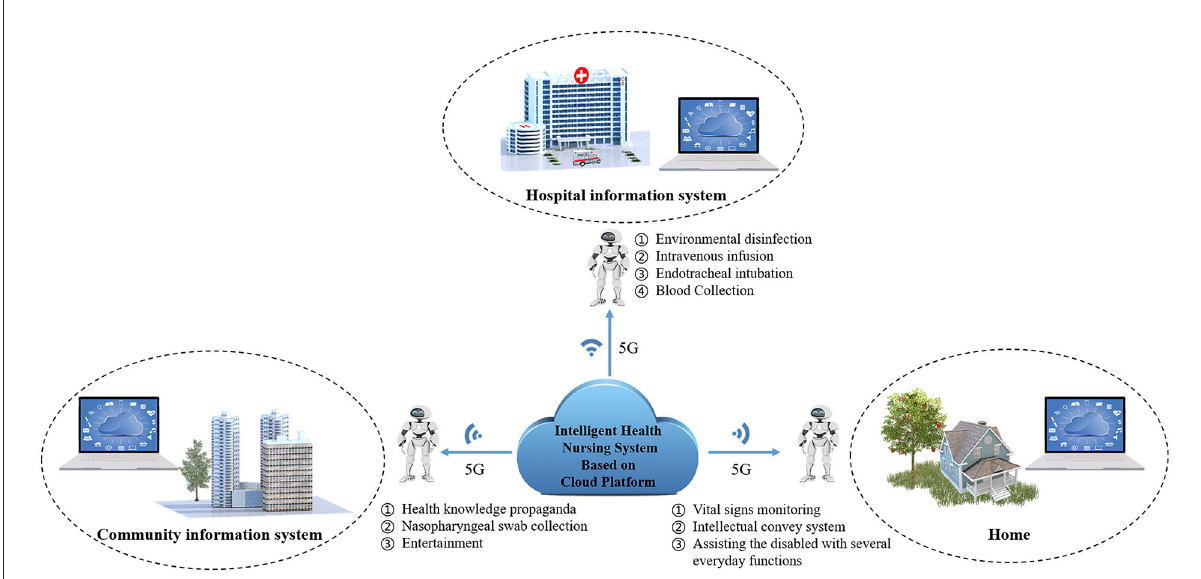
FIGURE2 The logical architecture of 5G network combined with AI robots in personalized nursing.